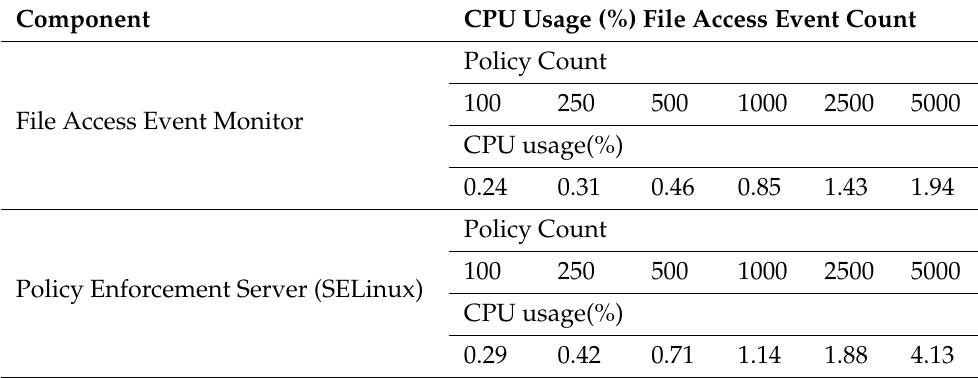
Table 5. CPU usage file access event notification using the policy enforcement server in SELinux.